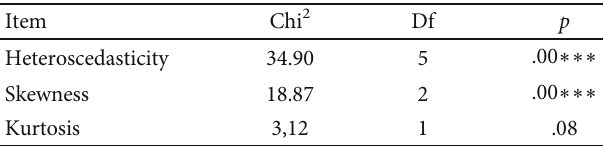
Table 5: Results of White ’ s test.